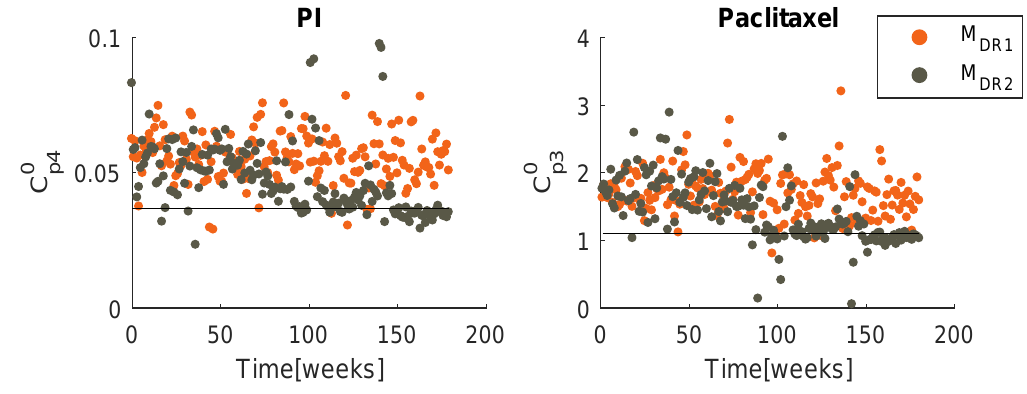
Figure 13. Best obtained PI prescription with both models ( N p = 40).